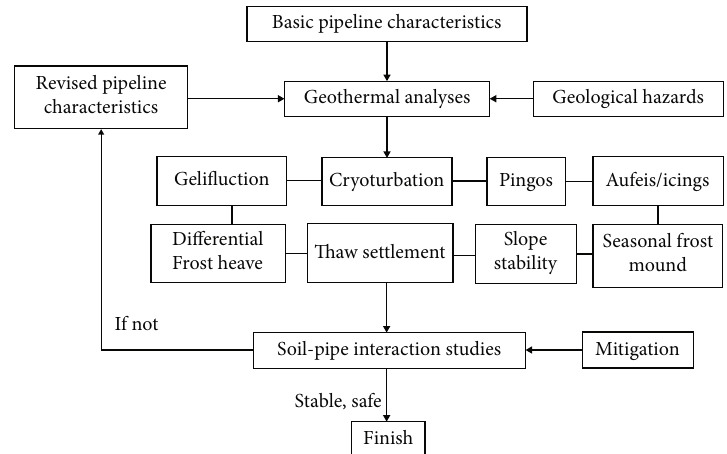
Figure 2: Flowchart of geotechnical input to cold region pipeline design modi fi ed by [2].